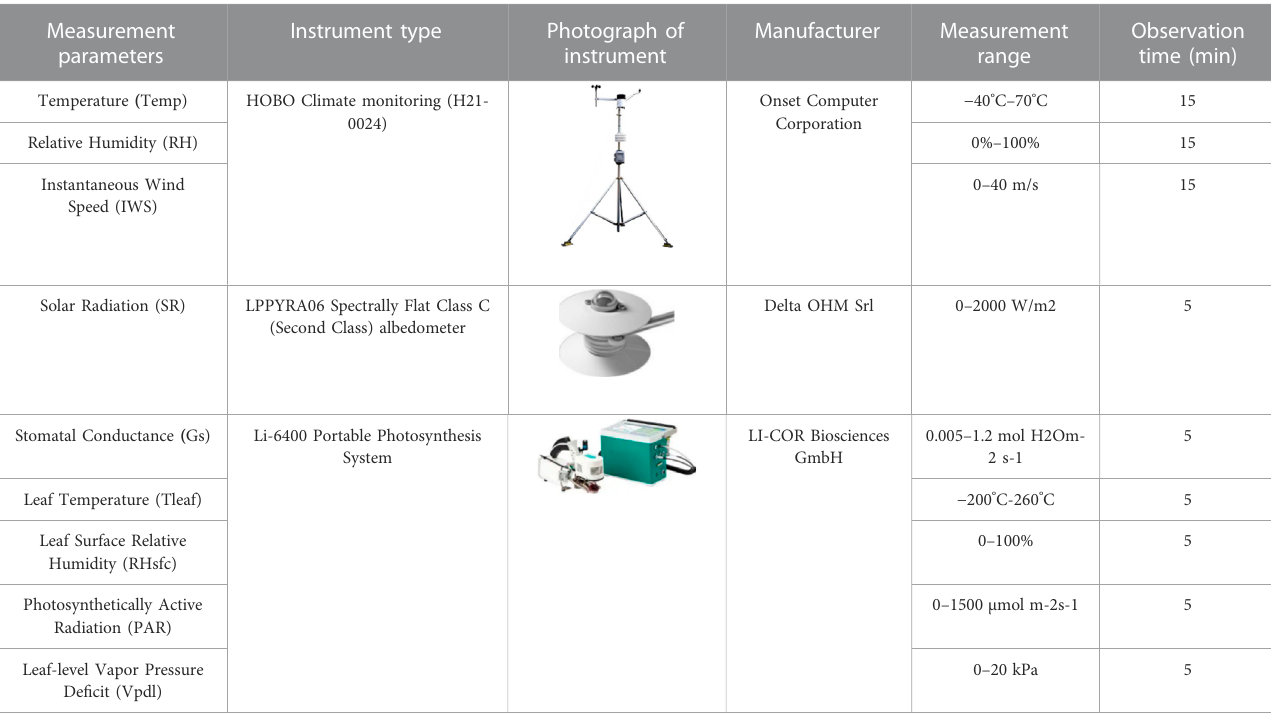
TABLE 4 The information of